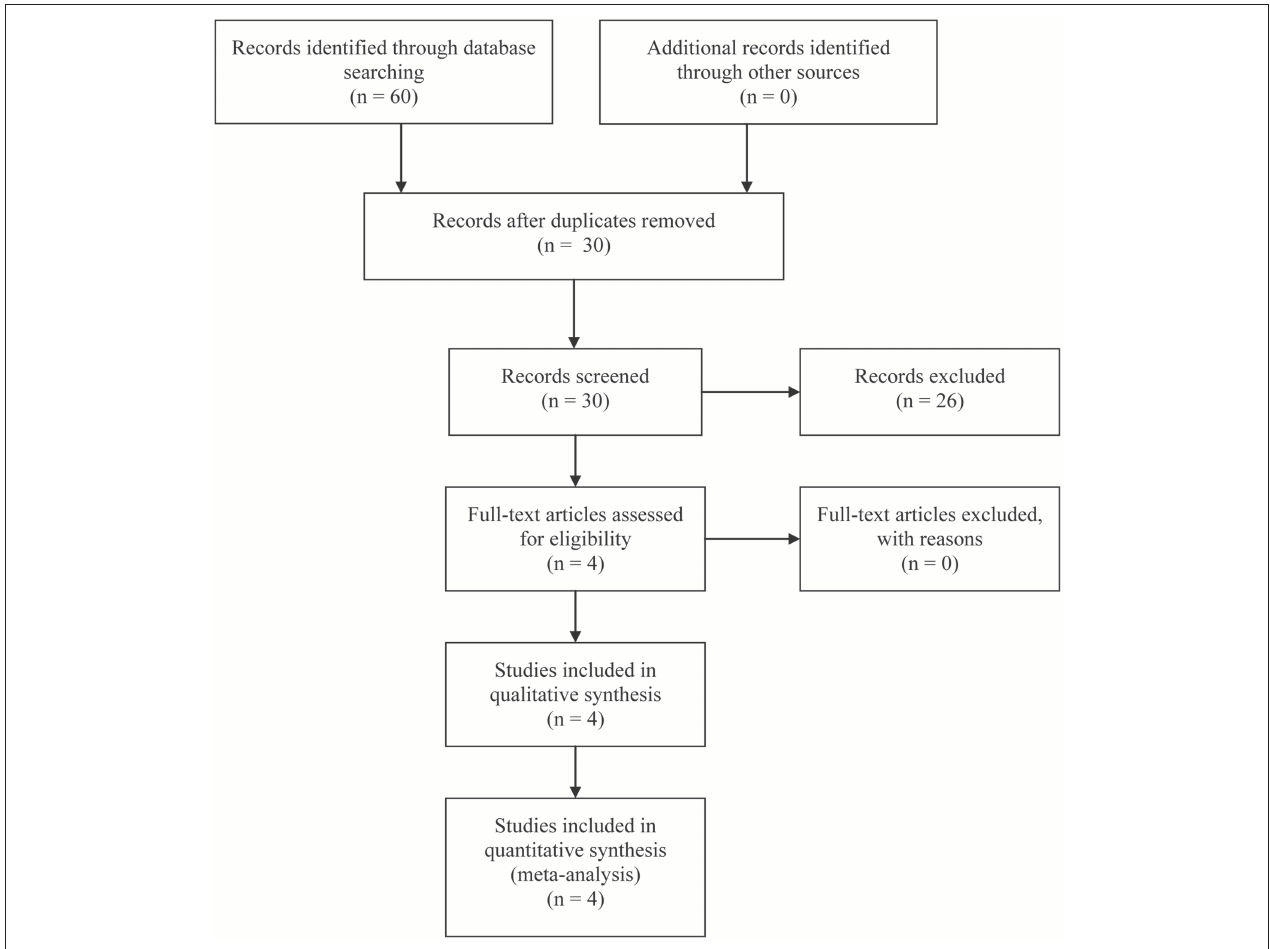
FIGURE 1 | Flow chart of citation retrieval and